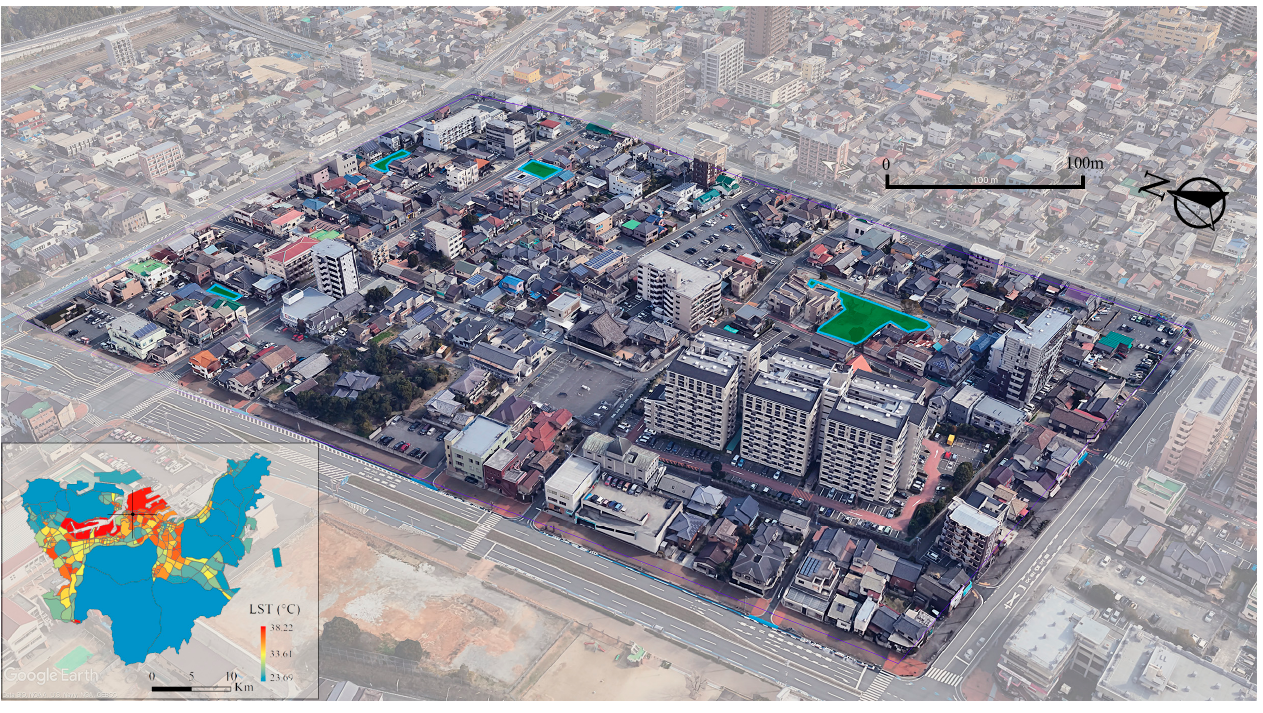
Figure 9. Realistic picture of a typical unit. Table 4. Indicators of a typical unit. Table 4. Indicators of a typical